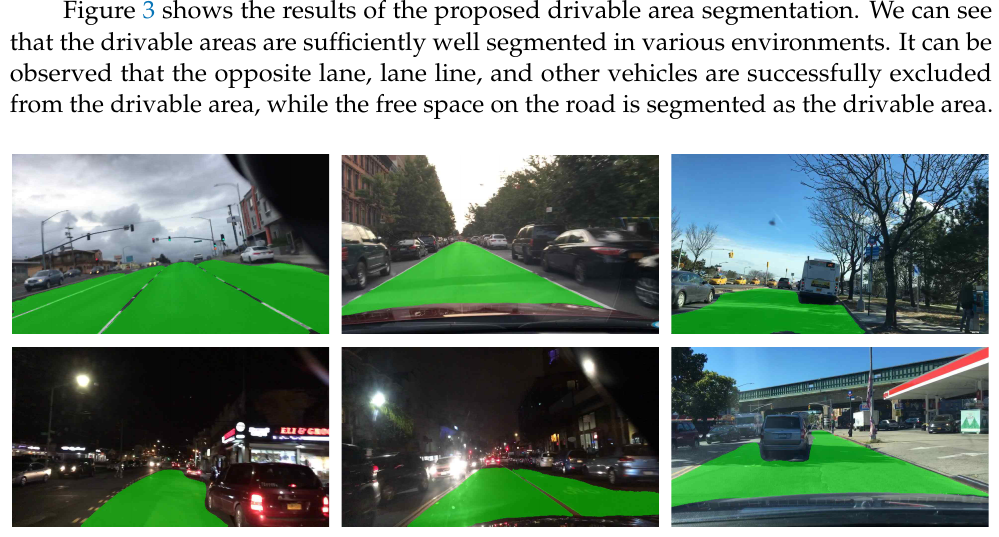
Figure 3. Examples of the drivable area segmentation